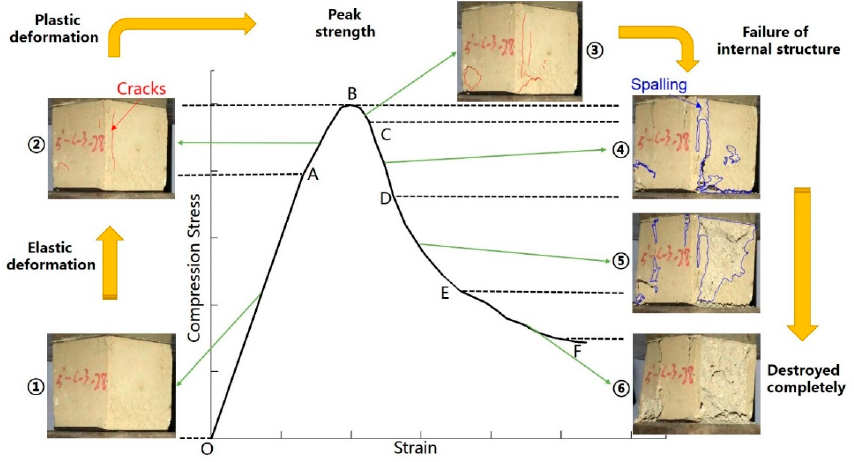
Figure 7. Compression failure process and characteristics of stress-strain curves of grouting material sample.